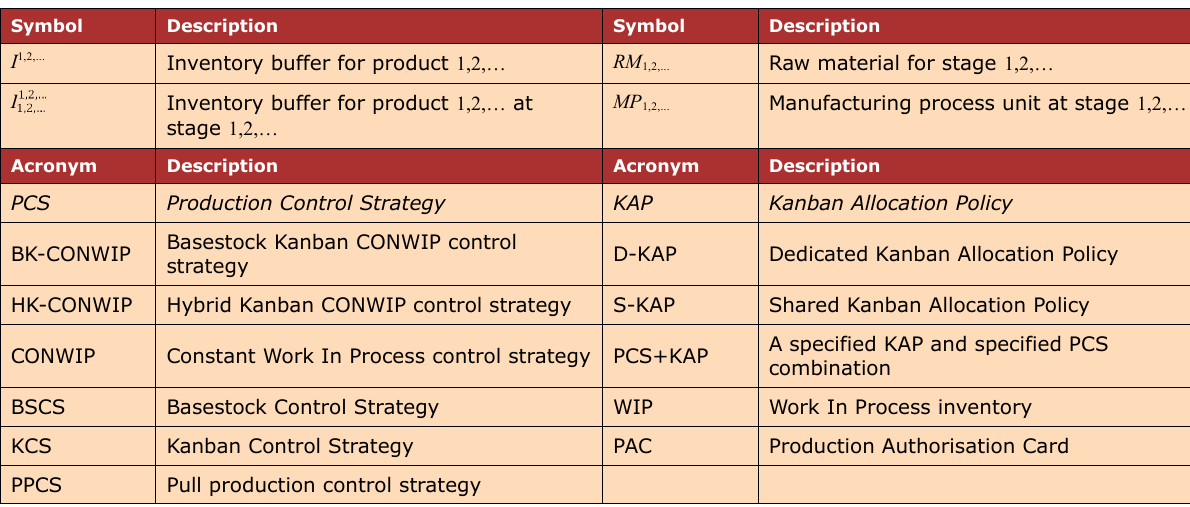
Table 2. Description of symbols and acronyms used in this paper